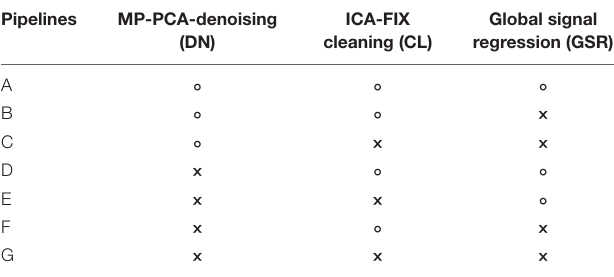
TABLE 1 | The seven data processing pipelines and methods they include (“ × ” – including, “ ◦ ” –